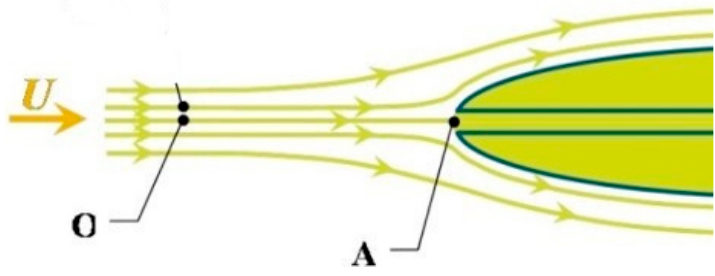
Figure 1. Total pressure measurement